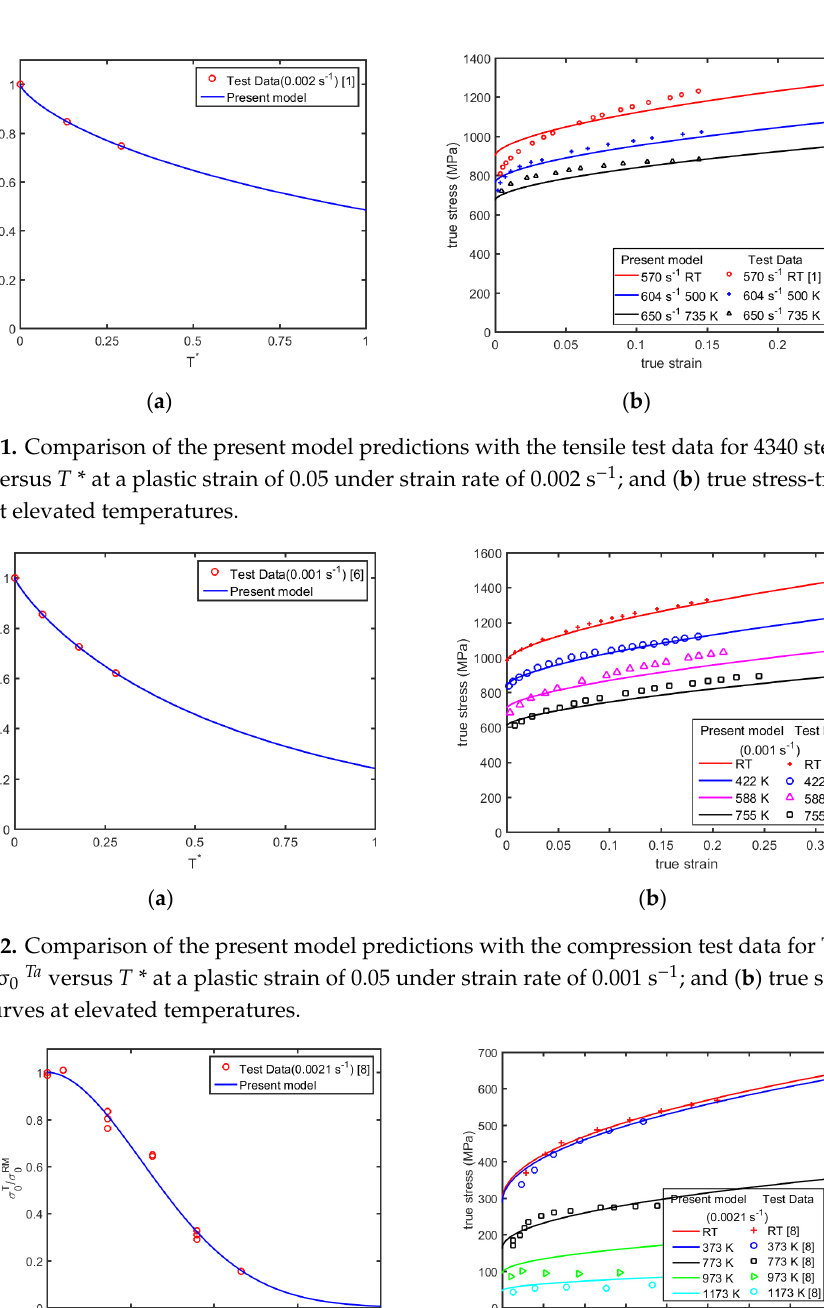
(cid:16) (cid:17) η η 2 − 1 [10–12]. It is apparent from Figure 2 3